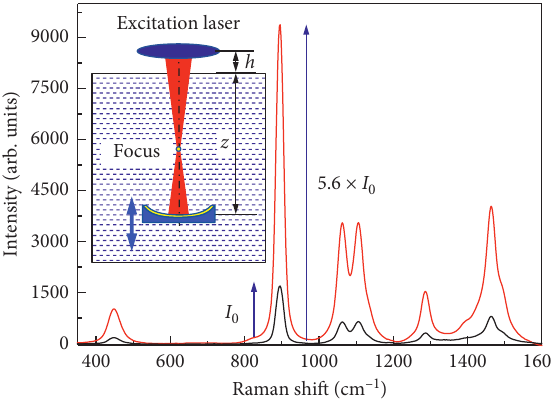
Figure 4: Raman-scattering spectra measured with (red) and without (black) a curved optical feedback mirror. Inset: schematic illustration of the experimental setup.